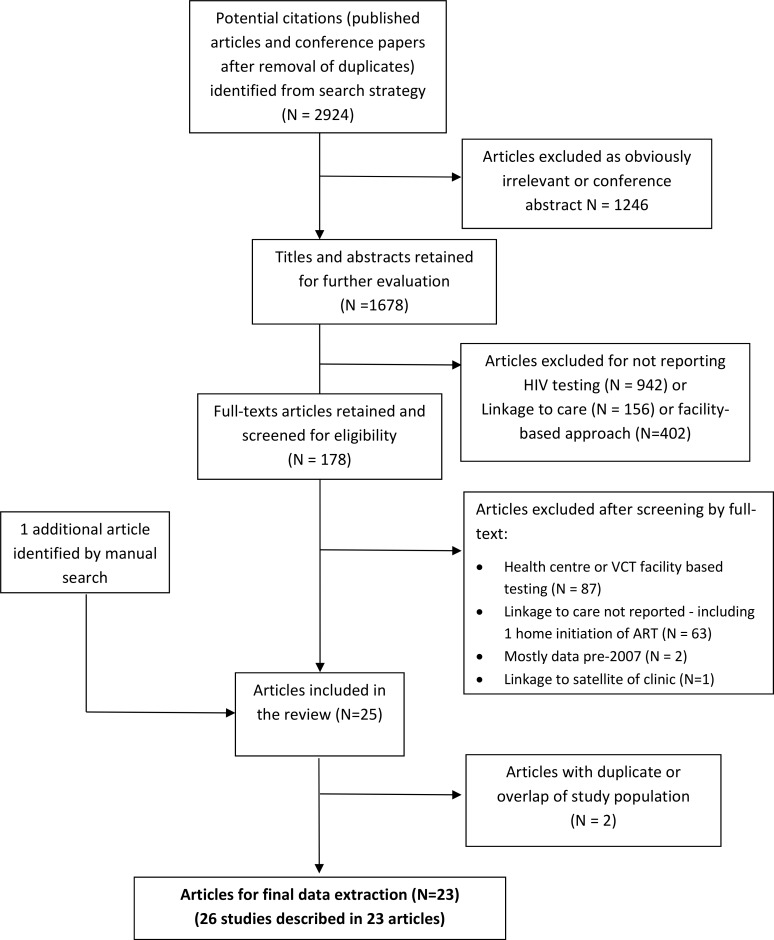
Flow diagram of study selection.